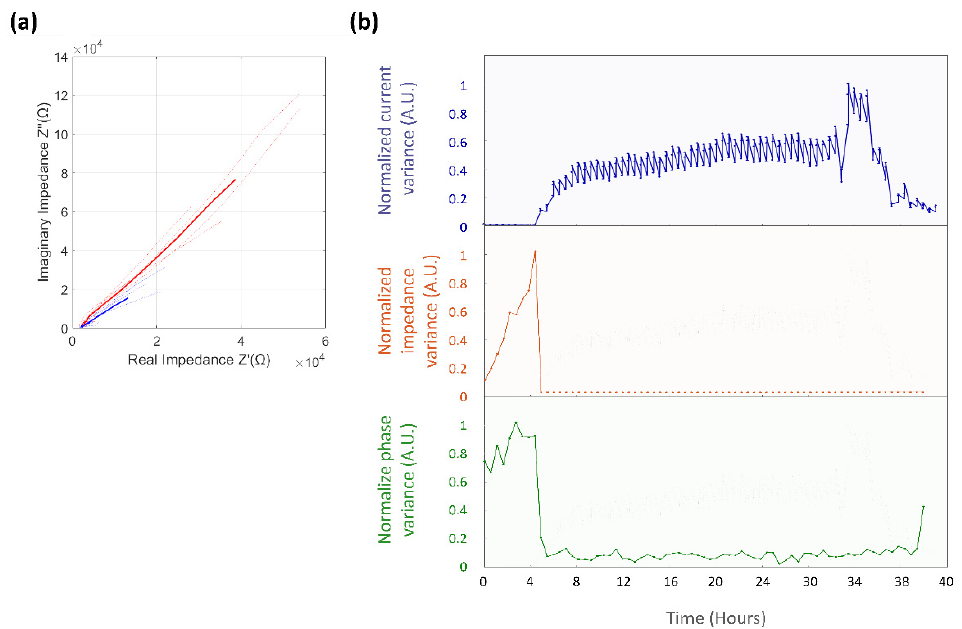
Figure 13. Analysis of EIS impedance and phase variance for microsystem colonization event experiment. ( a ) Nyquist plot for the EIS response before (Red) and after (Blue) the colonization event. ( b ) Comparison of the normalized variance for the CV current (Blue), EIS impedance (Orange) and EIS phase